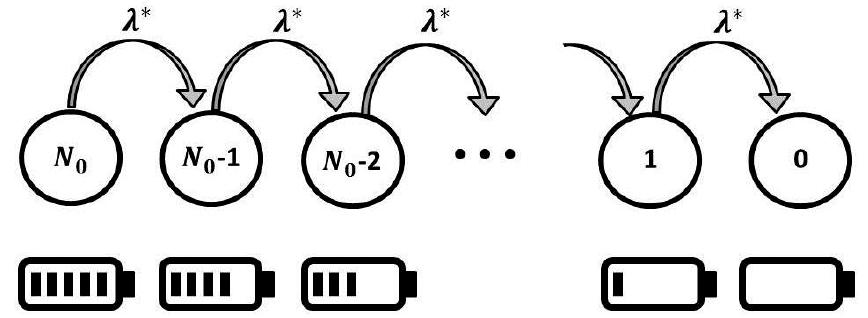
Figure 2. State diagram with absorbing state for sensor battery behavior.